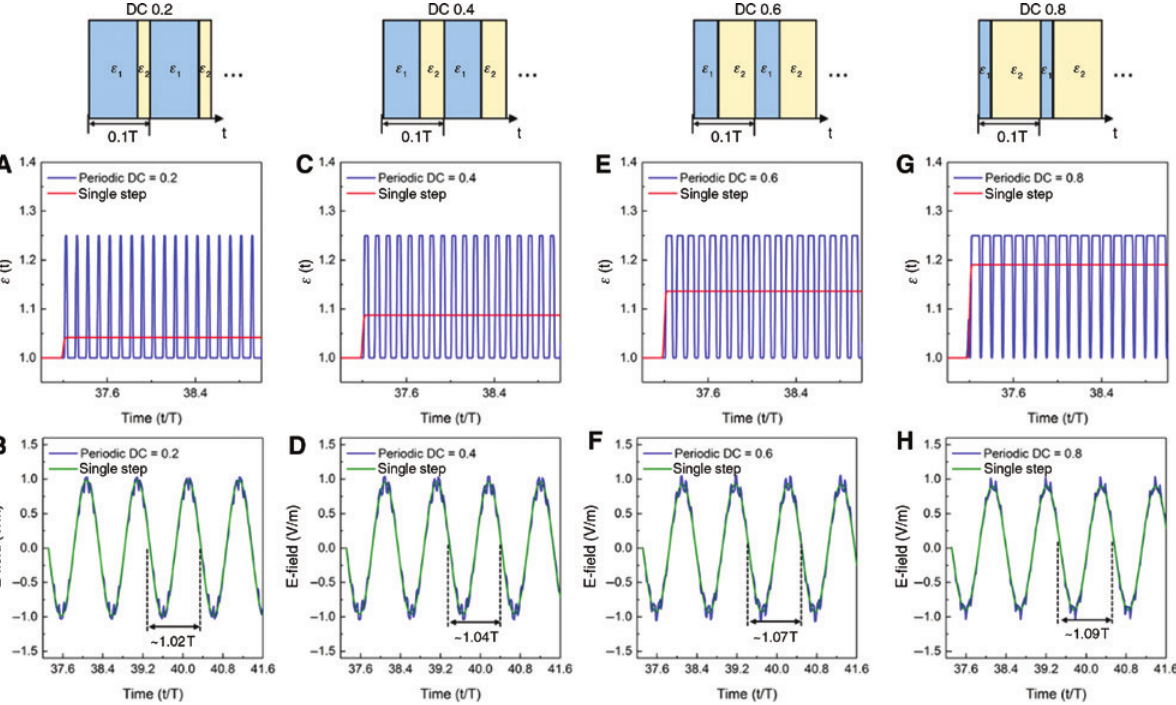
Figure 4: Effect of changing the duty cycle. (A, C, E, G) ε (t) considering a single step function (red lines) that is changed from 1 to ε = 1.041 (A), 1.087 (C), 1.136 (E) and 1.190 (G) along with the temporally periodic ε (t) (blue lines) changing from 1 to 1.25 with a periodicity of (1/10)T and a duty cycle (DC) of 0.2 (A), 0.4 (C), 0.6 (E) and 0.8 (G). (B, D, F, H) Simulation results for the electric field of the forward wave at a single location for the single step function (green lines) and temporally periodic ε (t) (blue lines) considering the permitivities shown in panels (A, C, E, G) with a duty cycle of 0.2 (B), 0.4 (D), 0.6 (F) and 0.8 (H). The schematic representations of the temporal multistepped metamaterials for each case are shown in the first